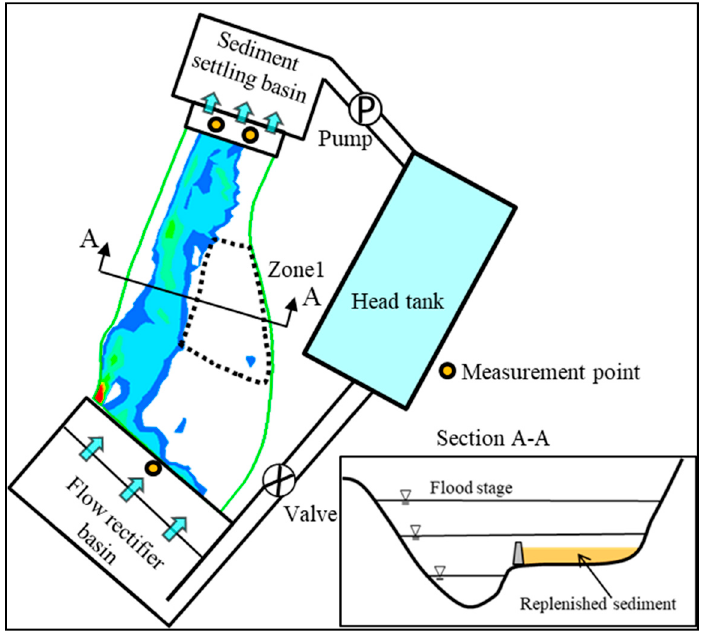
Figure 8. Layout of the physical model.